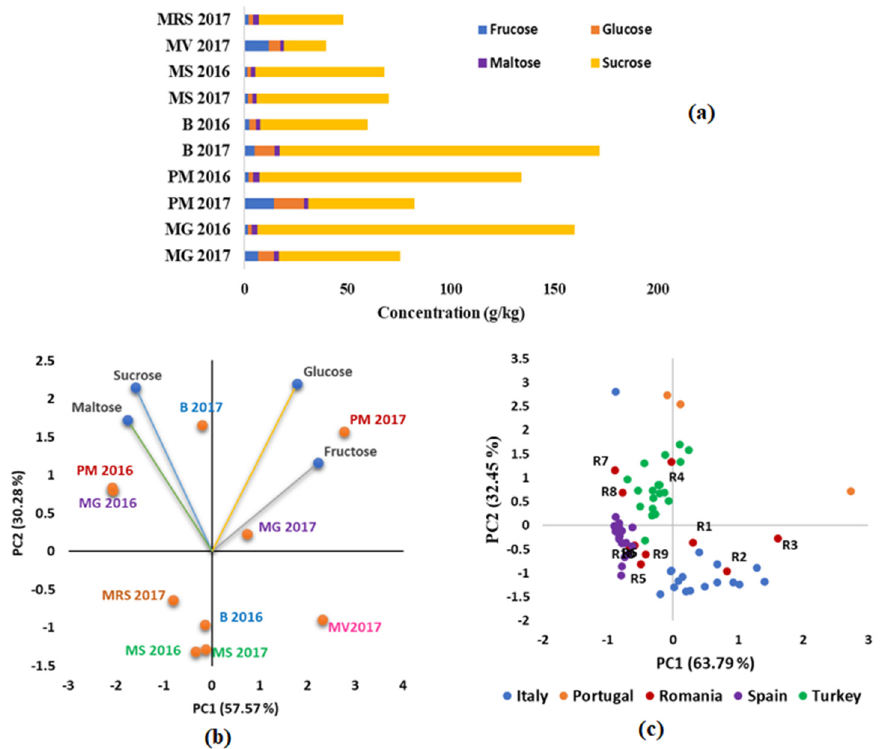
Figure 7. ( a ) Sugar profile of the analyzed chestnut cultivars harvested in 2016 and 2017; ( b ) Principal Component Analysis (PCA) of the fruits of different chestnut cultivars based on individual phenolic compounds (‘Précoce Migoule’—PM, ‘Bournette’—B, ‘Marsol’—MS, ‘Marissard’—MRS, ‘Marigoule’—MG and ‘Maraval’—MV); ( c ) PCA analysis based on sugar composition of chestnut fruits harvested in some European countries .